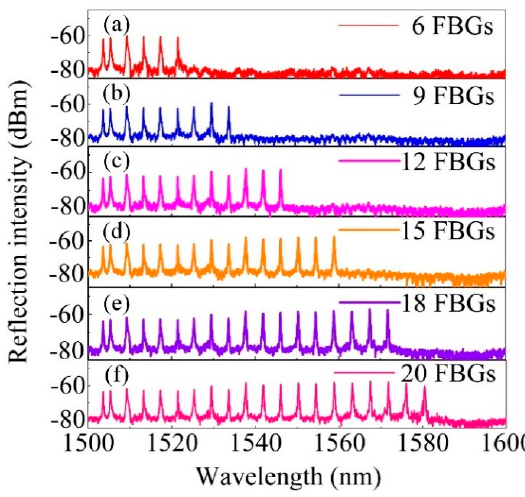
Figure 7. Reflection spectra evolution ( a – f ) of an FBG array inscribed in a H 2 -loaded SMF. The minimum and maximum resonant wavelengths of an FBG array inscribed by the proposed Talbot interferometer without compensating of OPD were experimentally explored. From Table 1